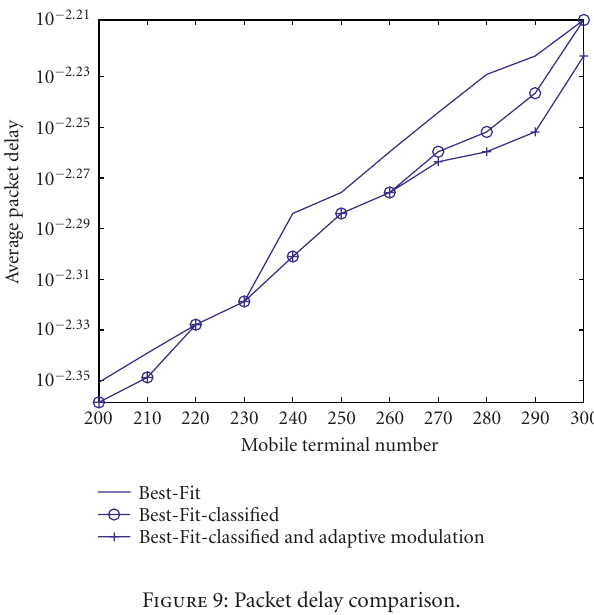
Figure 9: Packet delay